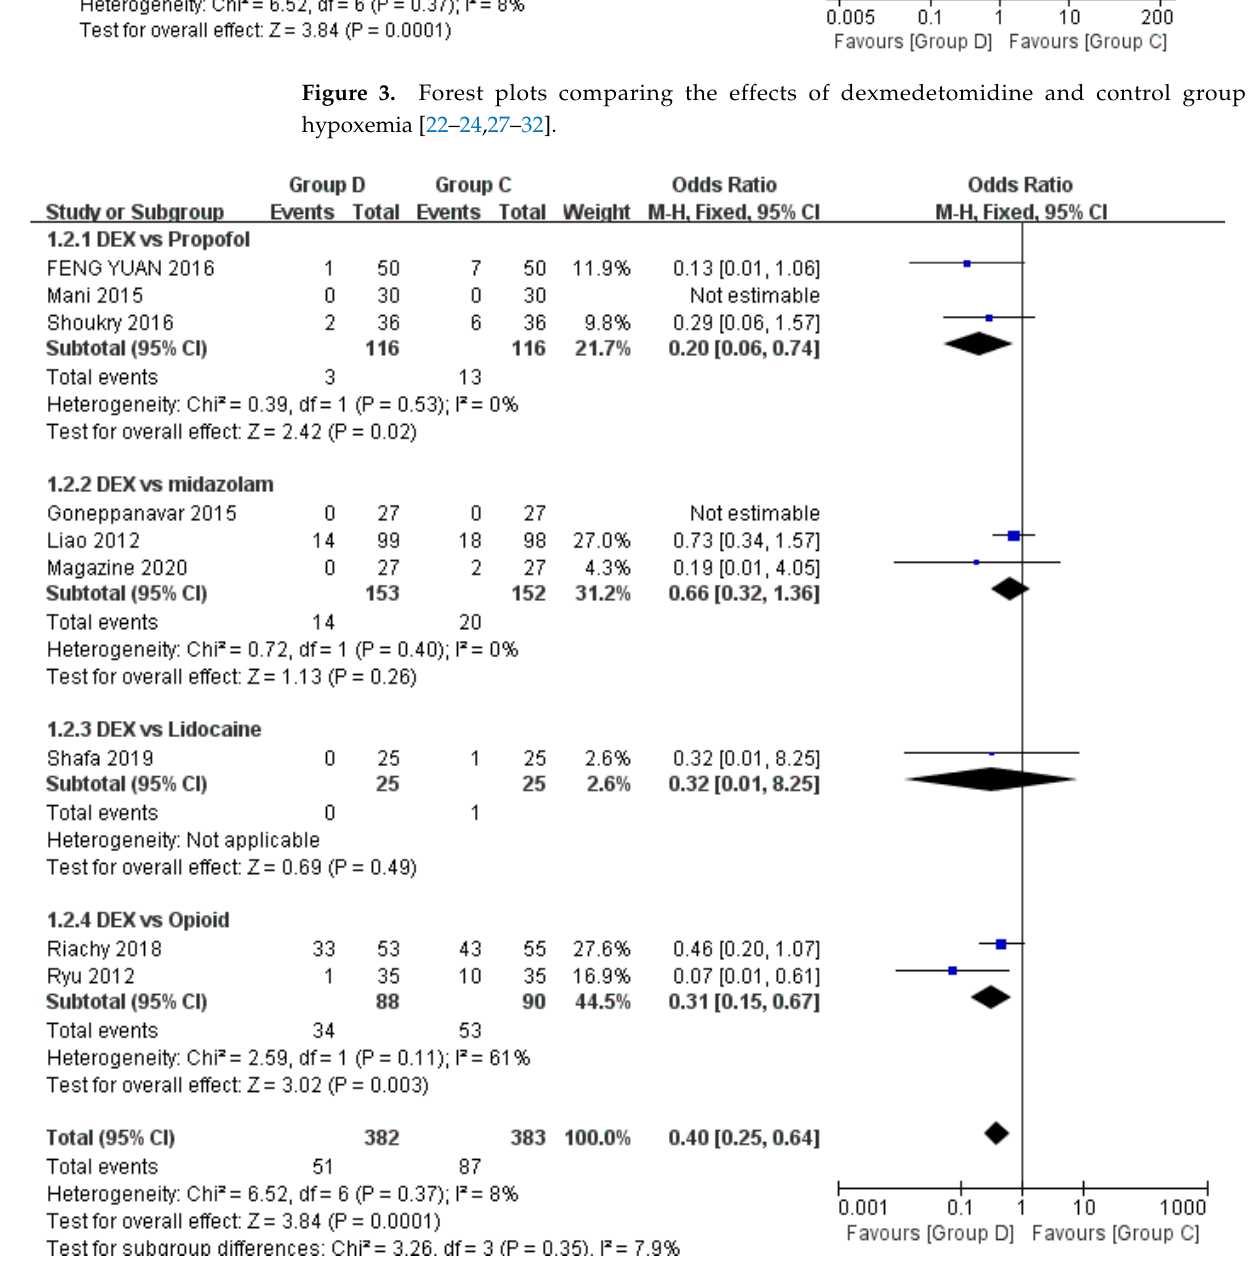
Figure 4. Forest plots of subgroup analysis comparing the effects of dexmedetomidine and control group on hypoxemia [22–24,27–32].